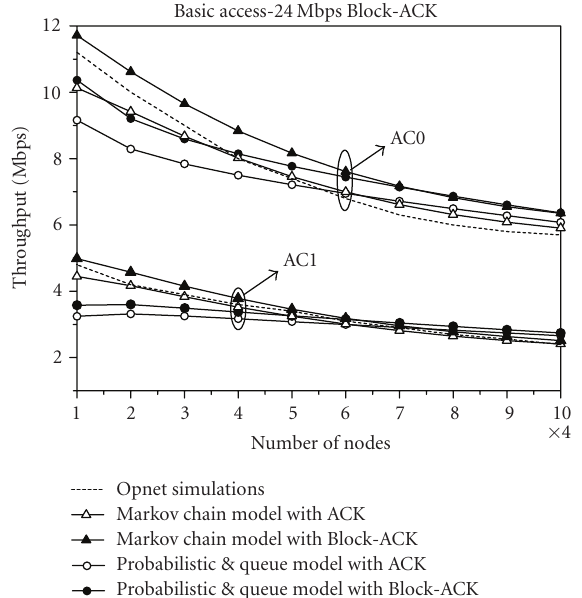
Figure 12: Model comparison of saturation throughput with Block-ACK being enabled (F = 64) in 24Mbps with IEEE